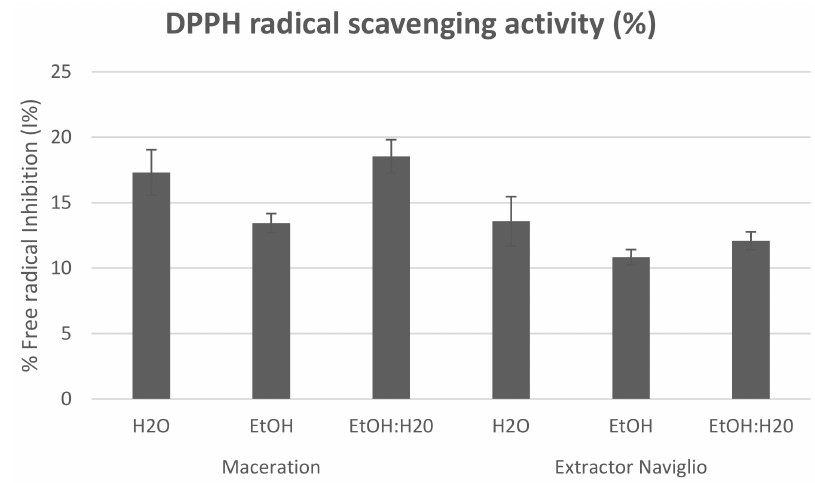
Figure 2. DPPH radical scavenging activity of OFP extracts by ME and NE methods with different solvents. The results are expressed as ‘% free radical inhibition (I%)’. Table 3. OFP extract samples subjected to UHPLC/UV-ESI-HRMS analysis.